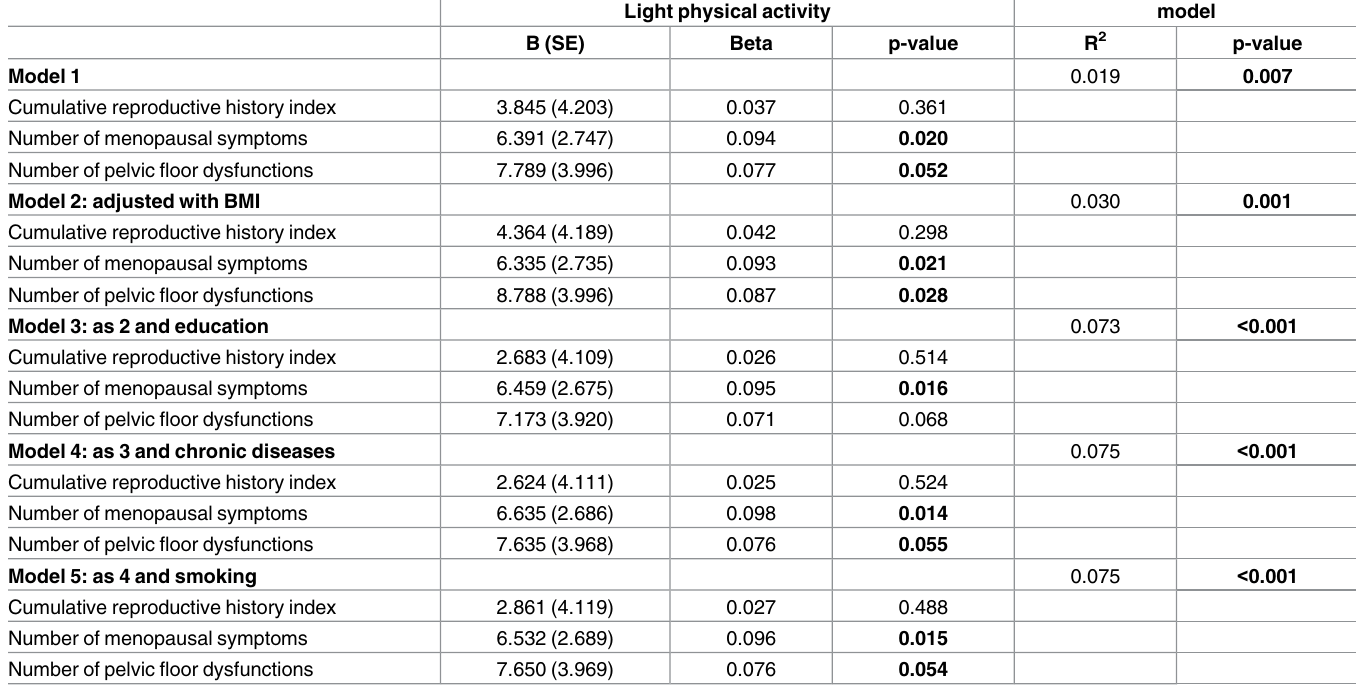
Table 4. Multiple linear regression analysis of light intensity physical activity as dependent